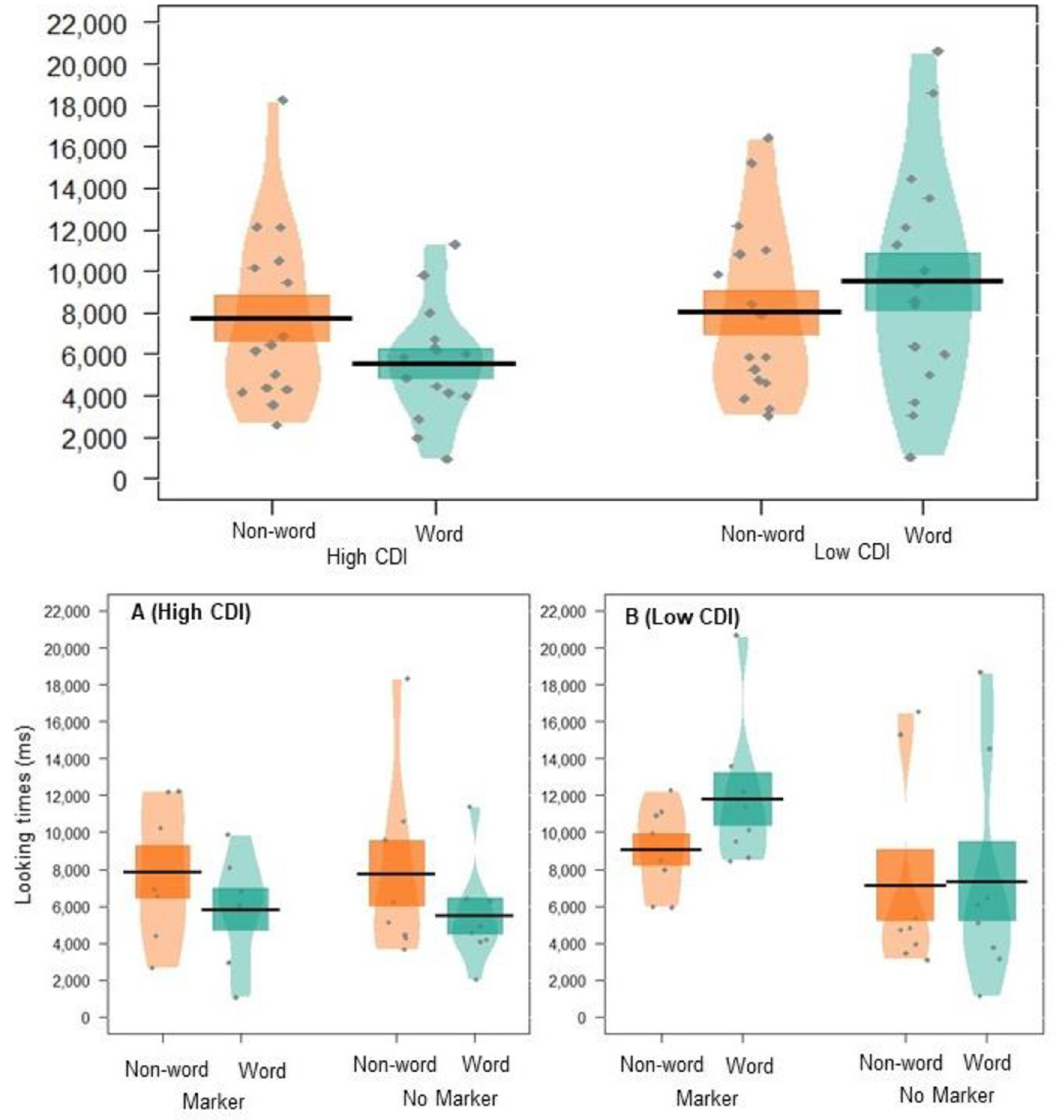
Fig 2. Pirate plot depicting the (raw) mean looking times to words and non-words for the participants in experiment 1. The top panel displays this data for High and Low CDI groups. The bottom panel breaks this down into each markers condition, with the High CDI group in panel A and the Low CDI group in panel B. Black lines indicate the mean, and coloured blocks indicates SE . Coloured shapes show the distribution of looking times for each group, with individual data points in grey.